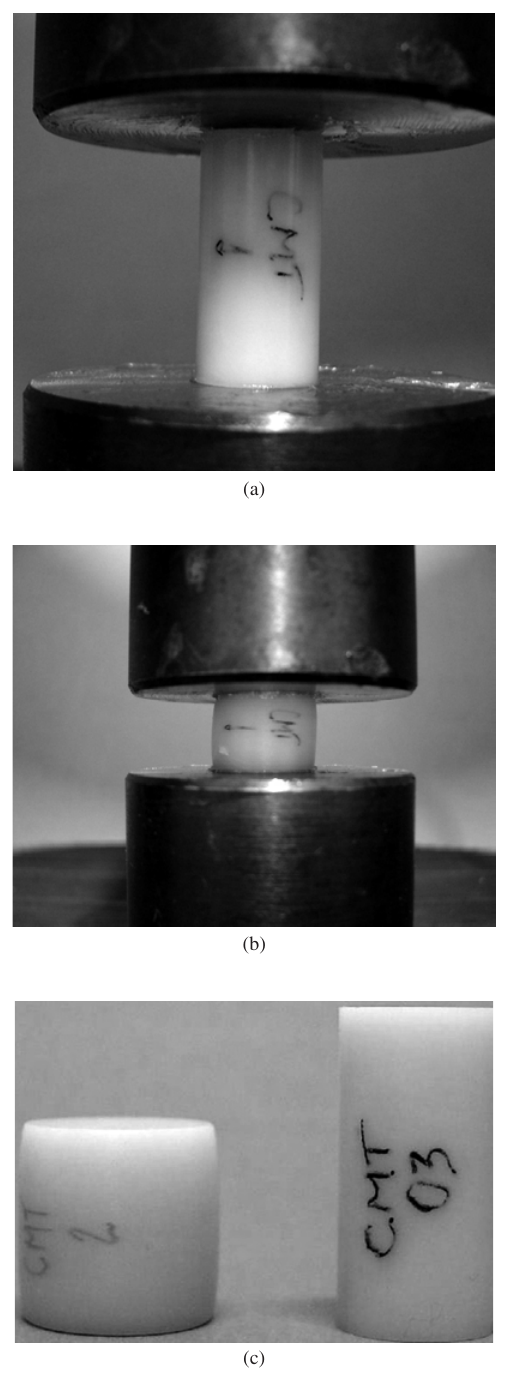
Figure 6. True Stress-strain curve: quasi-static, speed test = 0.8